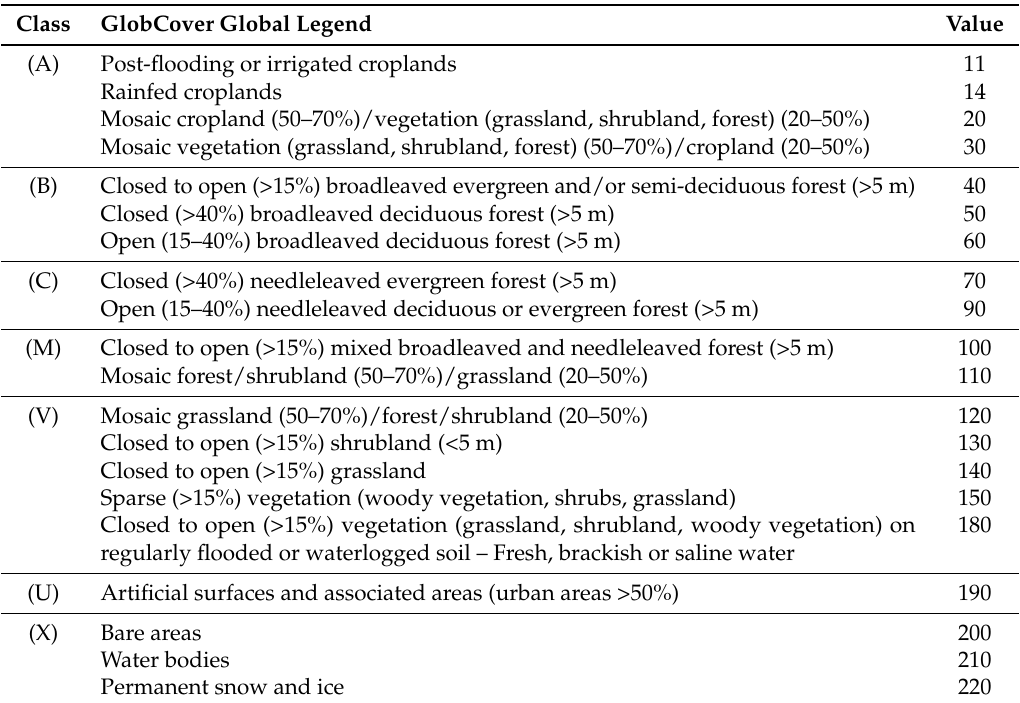
Table 2. GlobCover land cover types [26] occurring in the model area were combined into 7 main classes: (A) agriculture areas, (B) broad-leaved forest, (C) coniferous forest, (M) mixed forest, (V) low vegetation, (U) urban areas, and (X) unsuitable